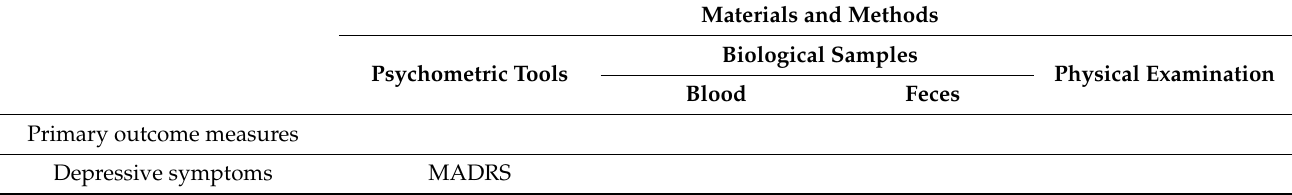
Table 1. Primary and secondary outcome measures. BMI: body mass index; BP: blood pressure; CRP: C-reactive protein; DASS: Depression, Anxiety, and Stress Scale; fGlc: fasting glucose; HDL-c: high- density protein cholesterol; MADRS: Montgomery–Åsberg Depression Rating Scale; MC: microbiota composition; MDA: malondialdehyde; SCFAs: short-chain fatty acids; TAC: total antioxidant capacity; TG: triglycerides; WBC: white blood cells; WC: waist circumference; WHOQOL-BREF: The